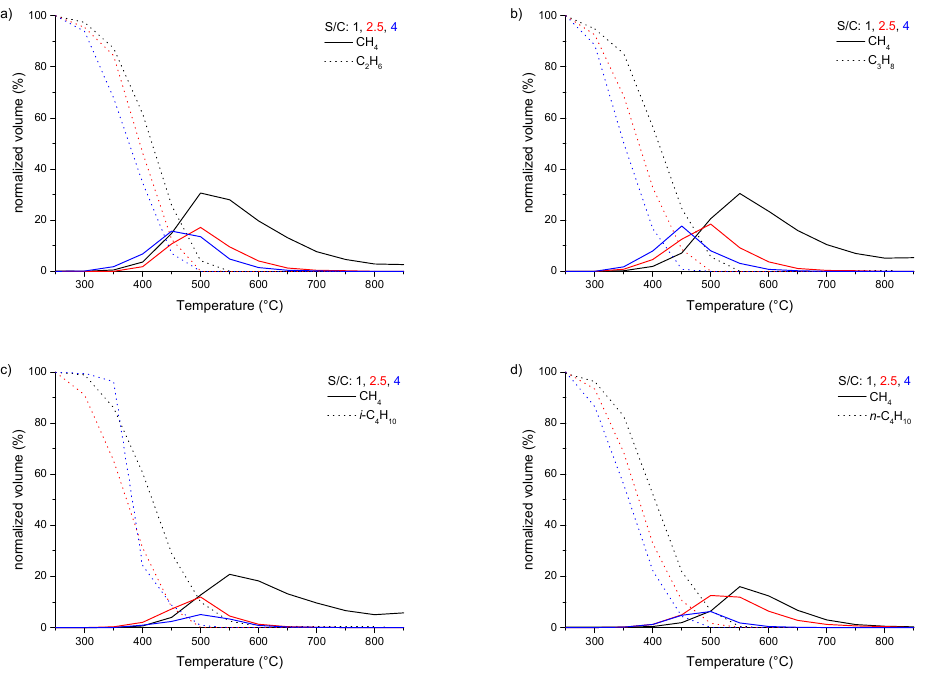
Figure 3. Formation of methane during steam reforming of ( a ) ethane, ( b ) propane, ( c ) i -butane and ( d ) n -butane over Rh1/Al 2 O 3 at various S/C ratios and temperatures at a constant GHSV of ~8000 h − 1 .